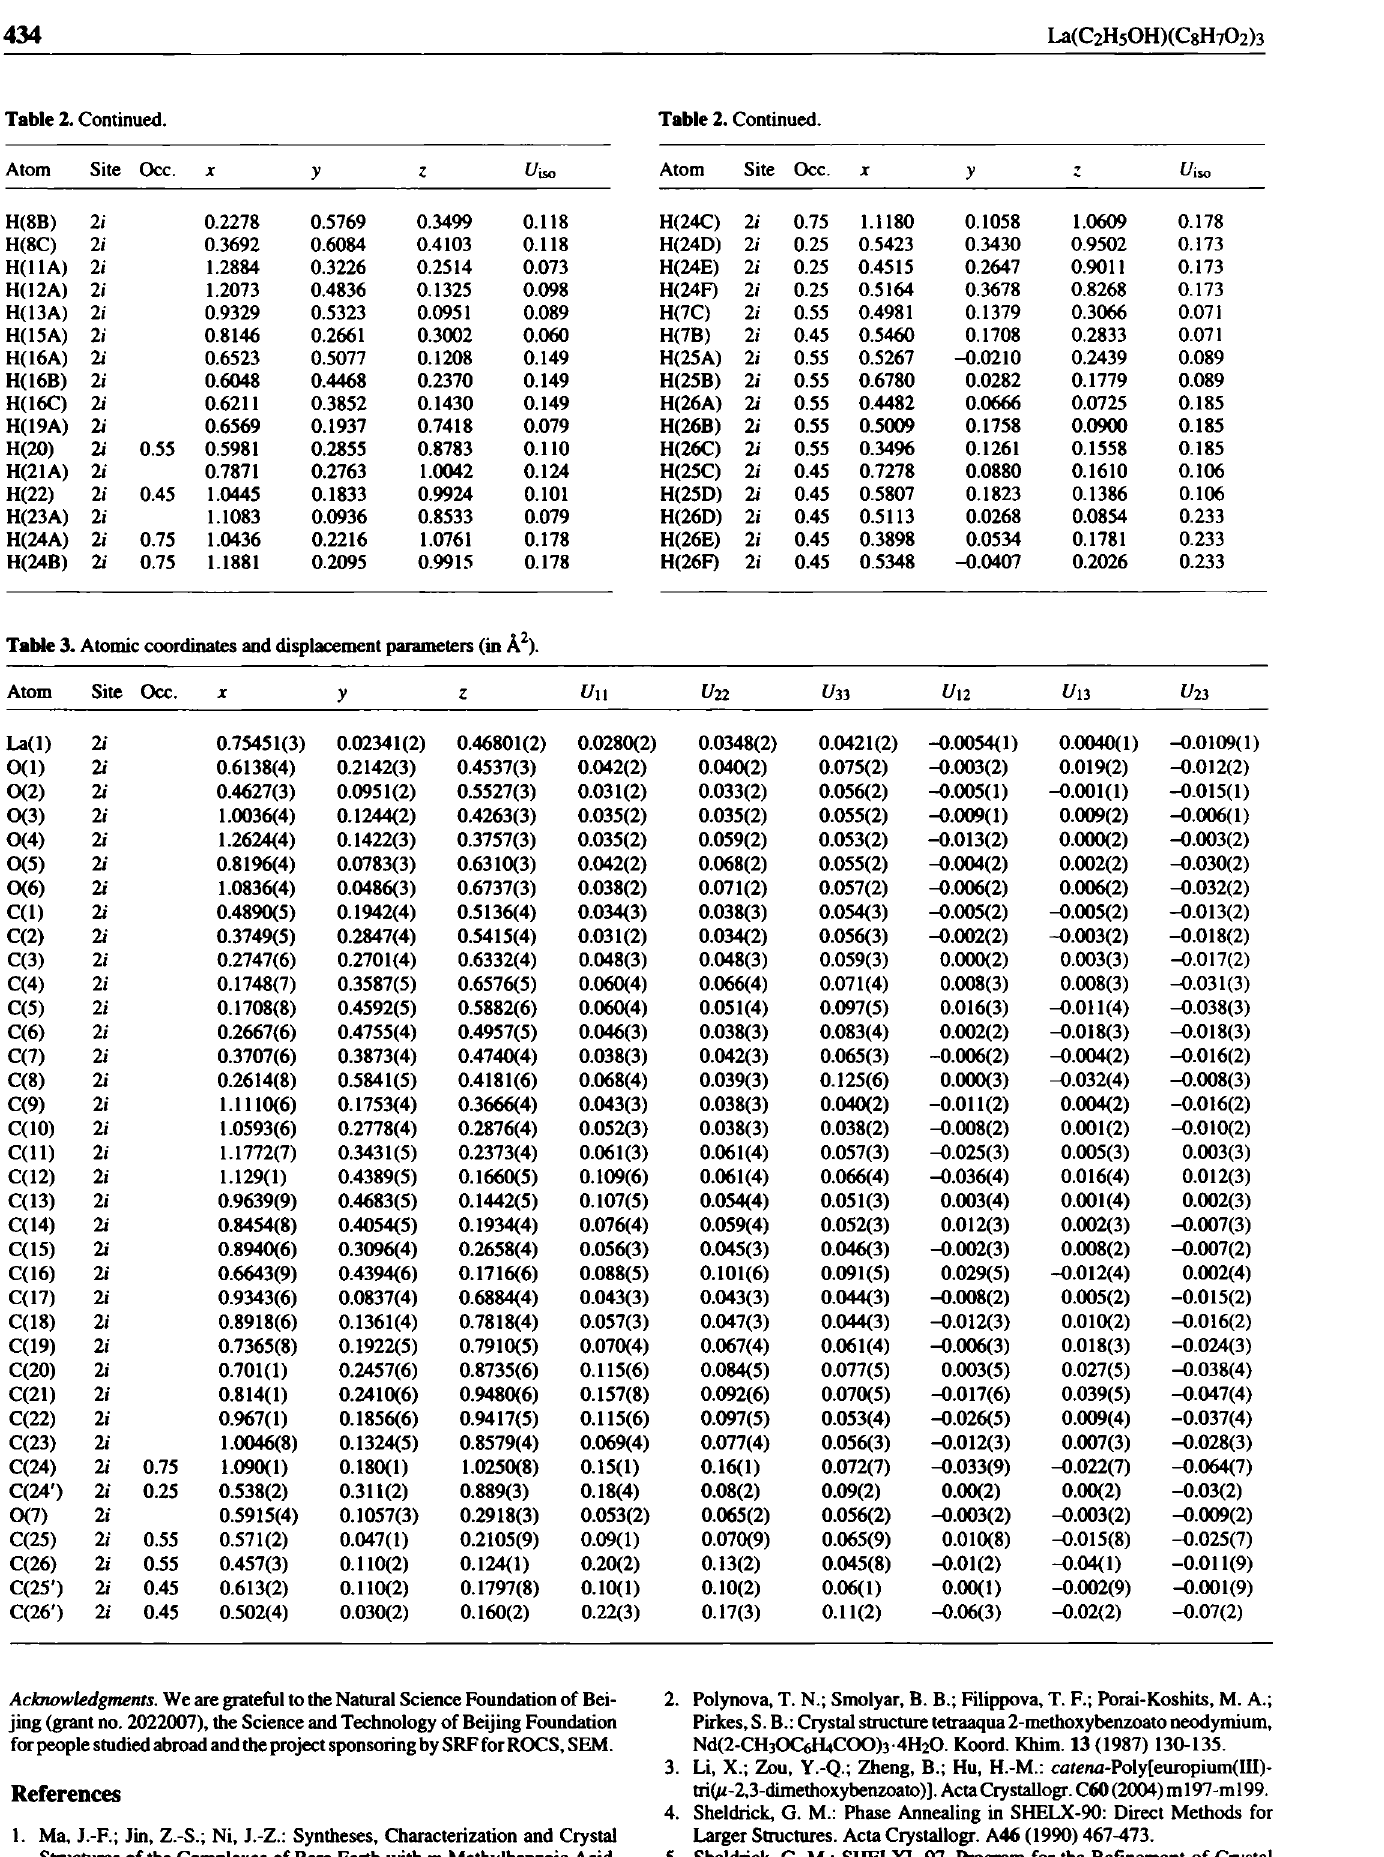
Table 3. Atomic coordinates and displacement parameters (in Â 2